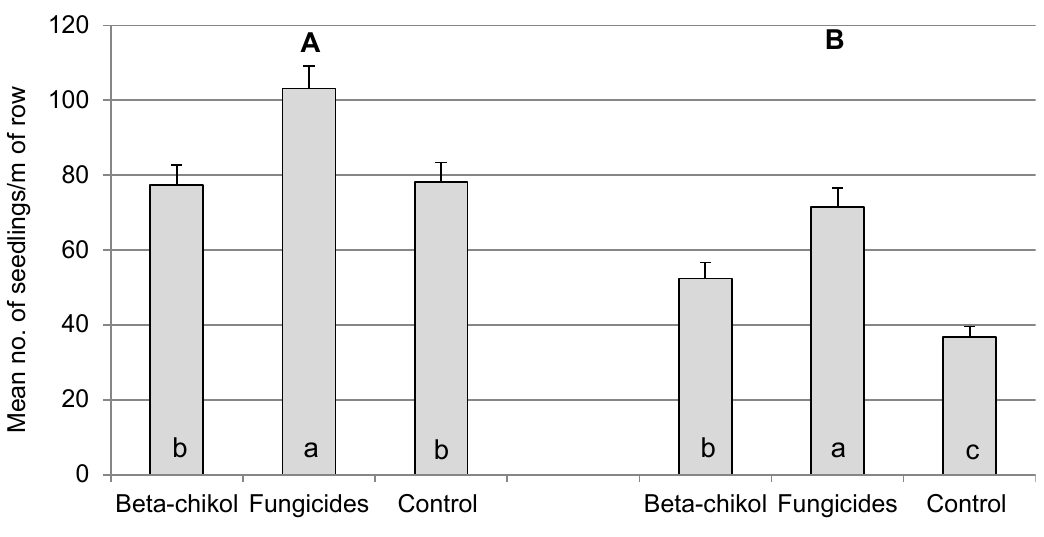
Figure 1. Mean number of Scots pine seedlings in 1-meter segments of the seed row ( A ) after seed germination and ( B ) approximately 7 weeks after germination in variants with Beta-chikol, fungicides, and no protection (control). Means marked with different letters are significantly different ( p < 0.05, Fisher’s LSD test). Error bars denote standard